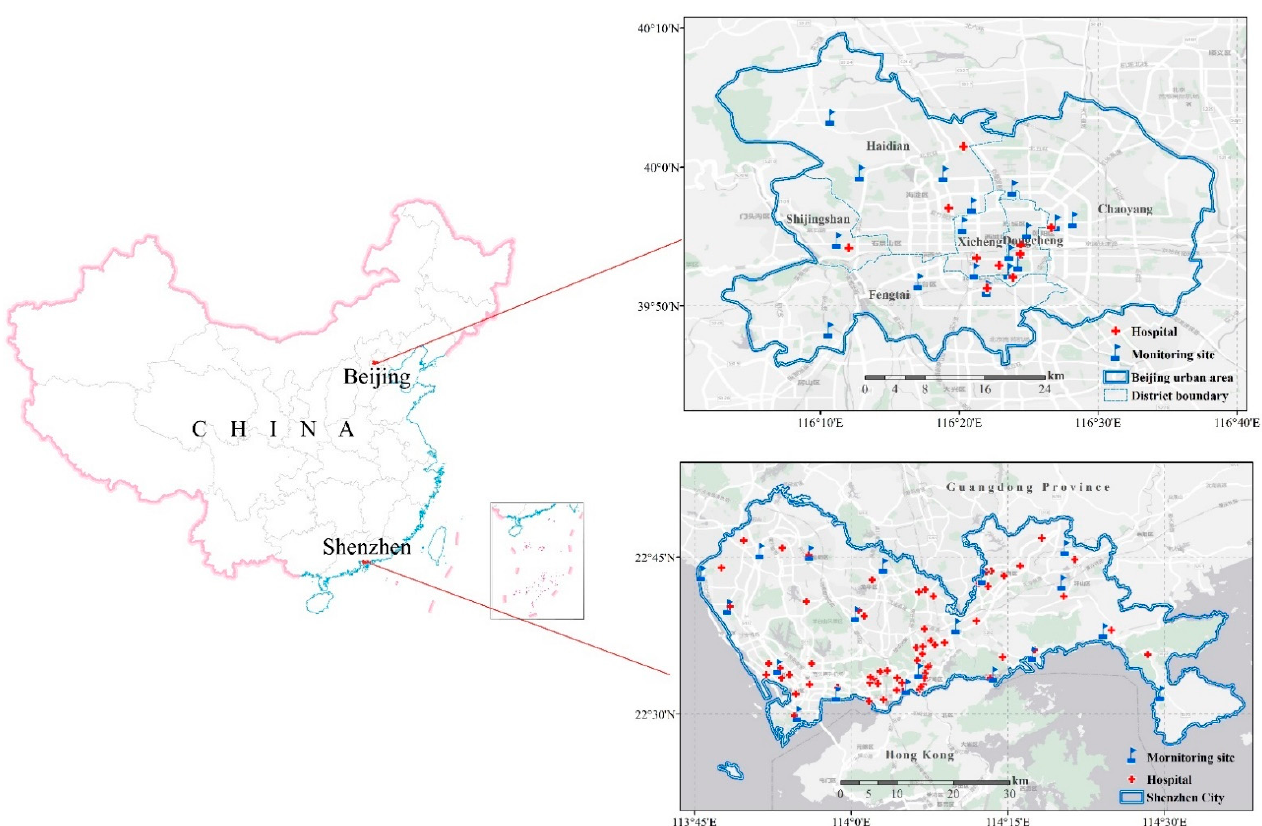
Figure 1. Distributions of selected hospitals and monitoring sites in Beijing urban areas and Shenzhen City.